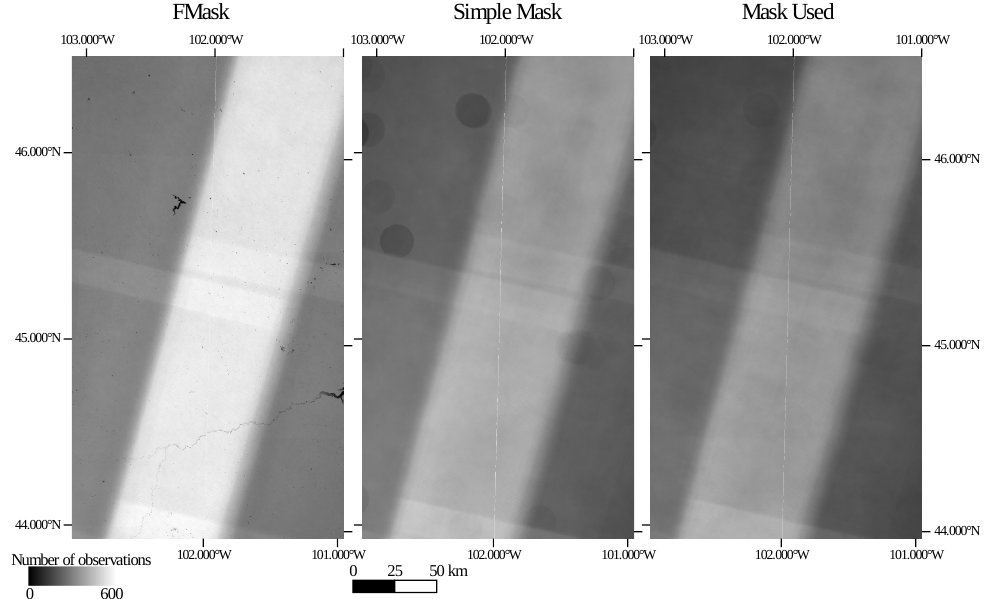
Figure A1. Number of observations available at each pixel across the study area for a given masking approach. The left panel is the number of clear observations for each pixel found by the Fmask procedure. This panel does not include pixels flagged as water, but water pixels are included in the analysis. The middle panel is the result of the simple masking approach. The right panel shows the observation density after the manual masking